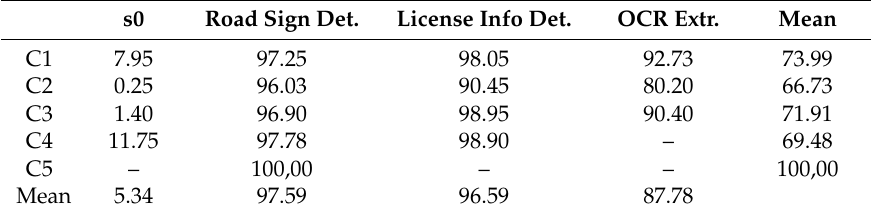
Table 4. Results for the Probabilistic Score on the 3120 × 4160 image pixel resolution. s0 Road Sign Det. License Info Det.